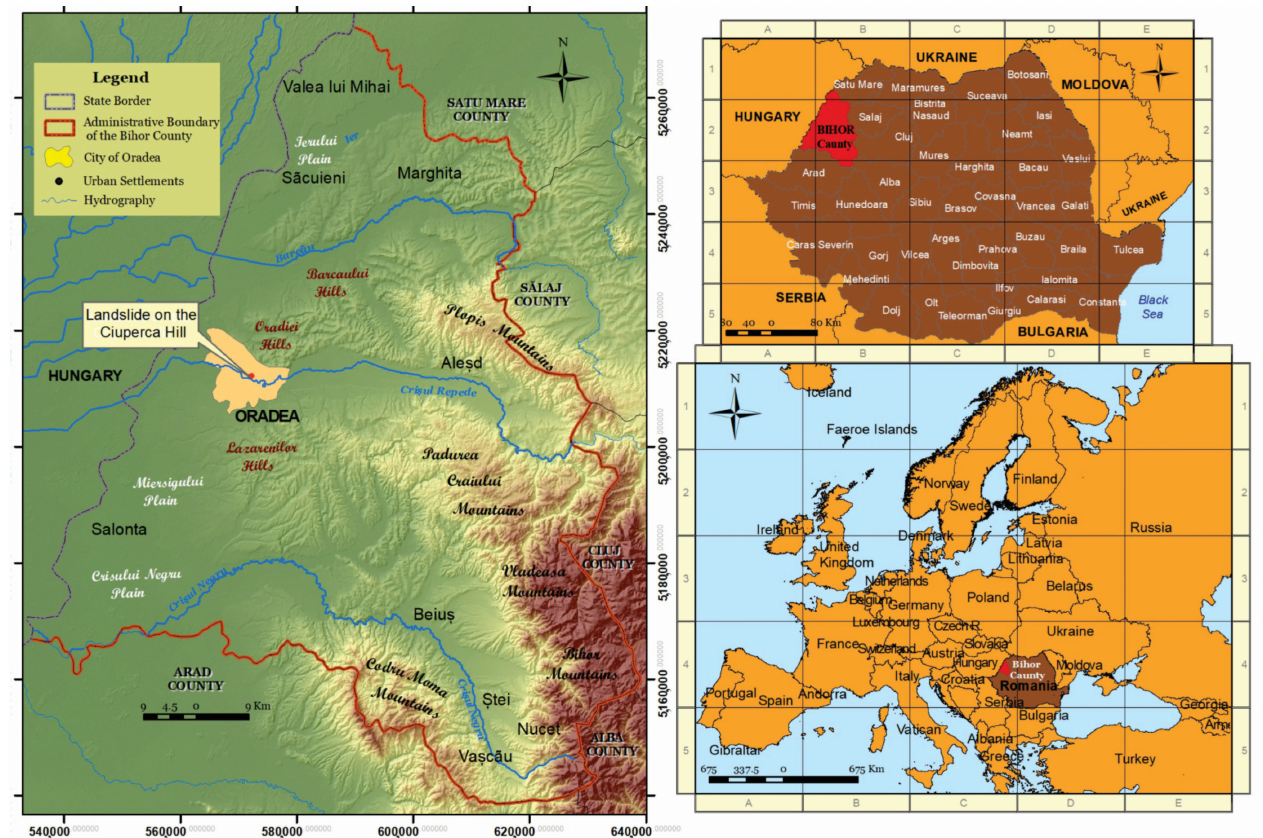
Figure 2. The Ciuperca Hill location within Bihor County, Romania. Data source: [38]. The study area is located in the city of Oradea and is known locally as Ciuperca Hill (elevation of 206.5 m) (Figure 3). It is the southwestern terminal part of the Oradiei Hills (component of the Western Hills of Romania). The hills are developed northeast of the city and look like long east–west oriented ridges. The neighboring plain area’s relief is displayed longitudinally, with higher altitudes (150–200 m) in the Pleistocene deposits of the eastern part and lower altitudes (80–120 m) in the Holocene deposits of the western part